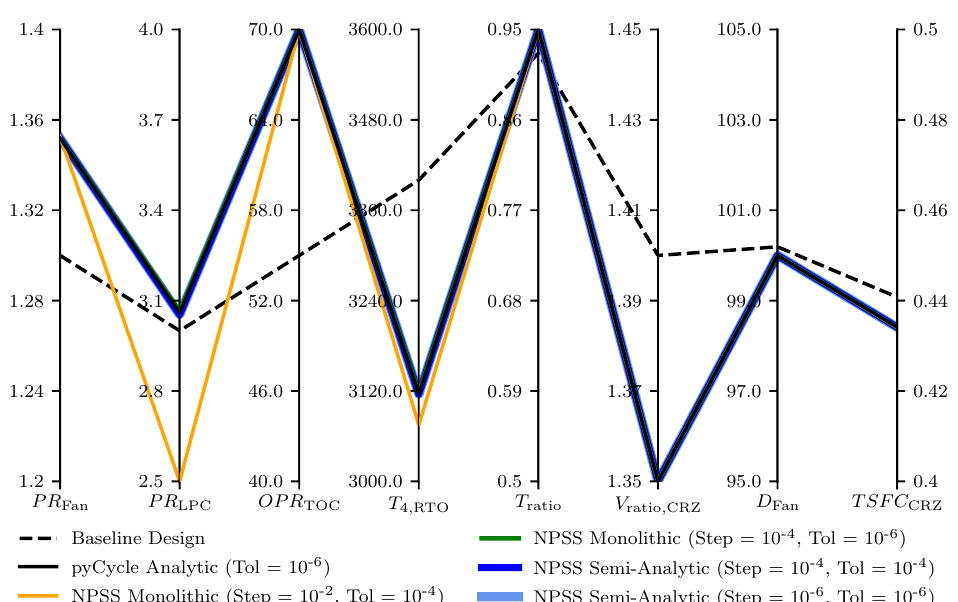
Figure 11. Optimal design variables, constraints, and objective values. (Note that the pyCycle analytic, NPSS monolithic (Step = 10 − 4 , Tol = 10 − 6 ), and both NPSS semi-analytic optimizations produced nearly identical results and are